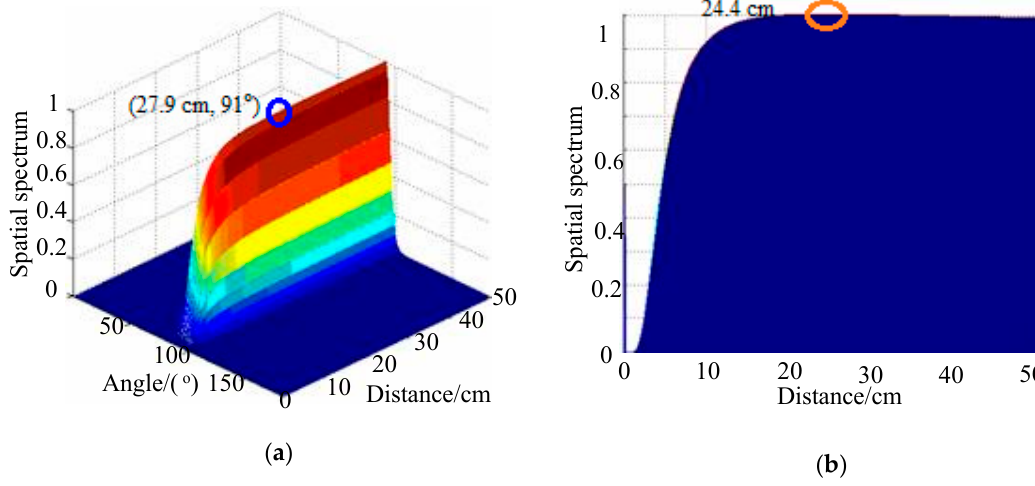
Figure 8. Spatial spectra of two methods under deformation degree 5 when PZTB was excited: ( a ) 2D-MUSIC algorithm; ( b ) TAM-MUSIC method.